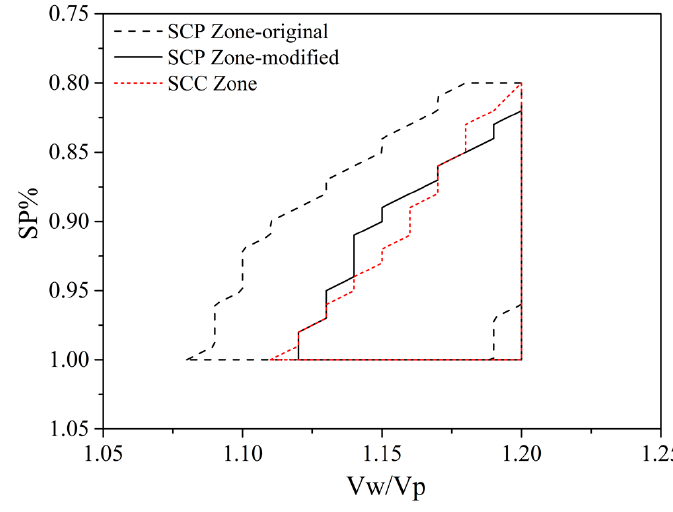
Figure 5. Self-compacting zones of series 1, cement.